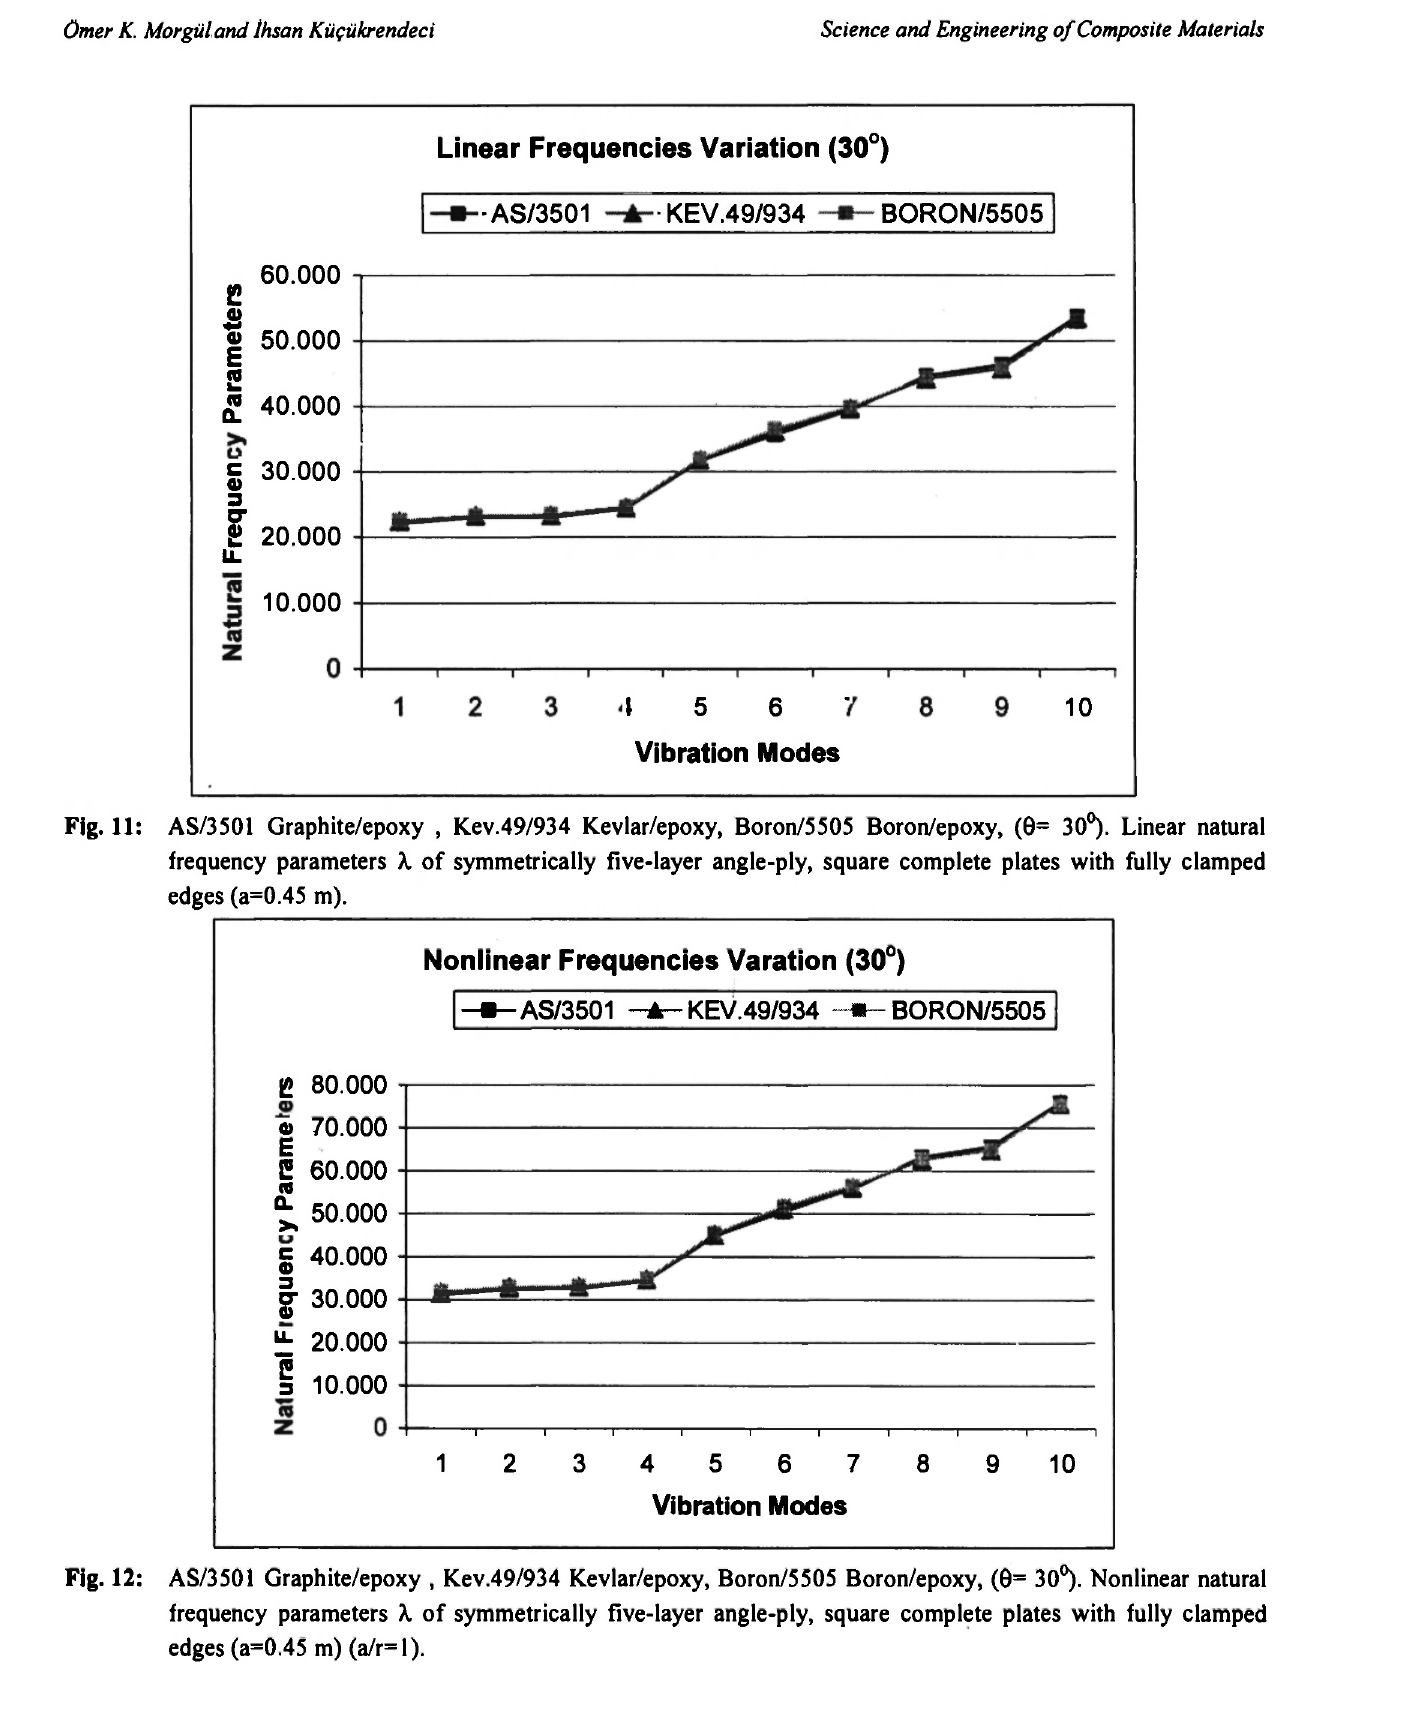
Fig. 12: AS/3501 Graphite/epoxy , Kev.49/934 Kevlar/epoxy, Boron/5505 Boron/epoxy, (θ= 30°). Nonlinear natural frequency parameters λ of symmetrically five-layer angle-ply, square complete plates with fully clamped edges (a=0.45 m)